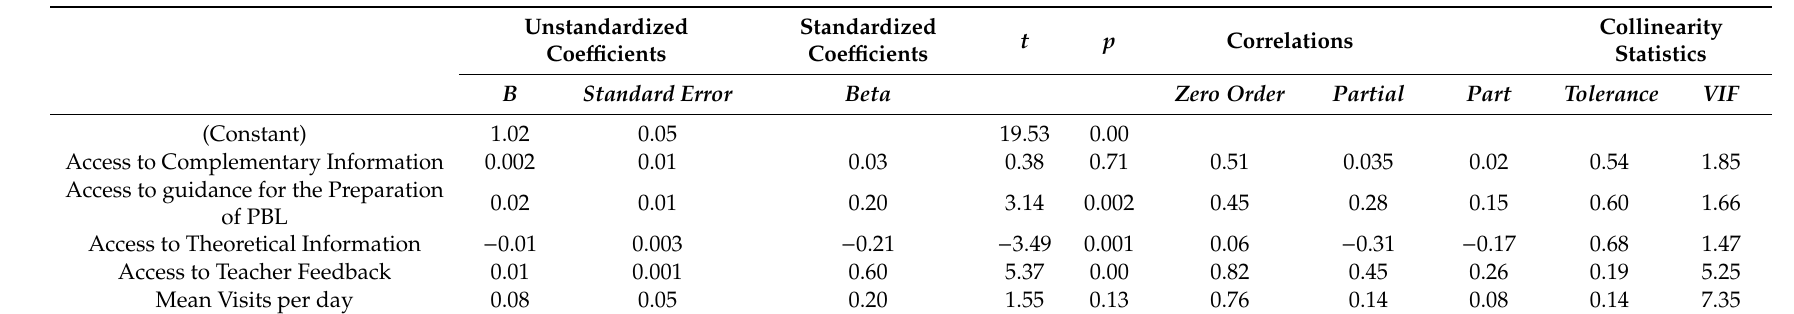
Table A4. Coe ffi cients in the prediction of Behavioral learning with variable types of Blended